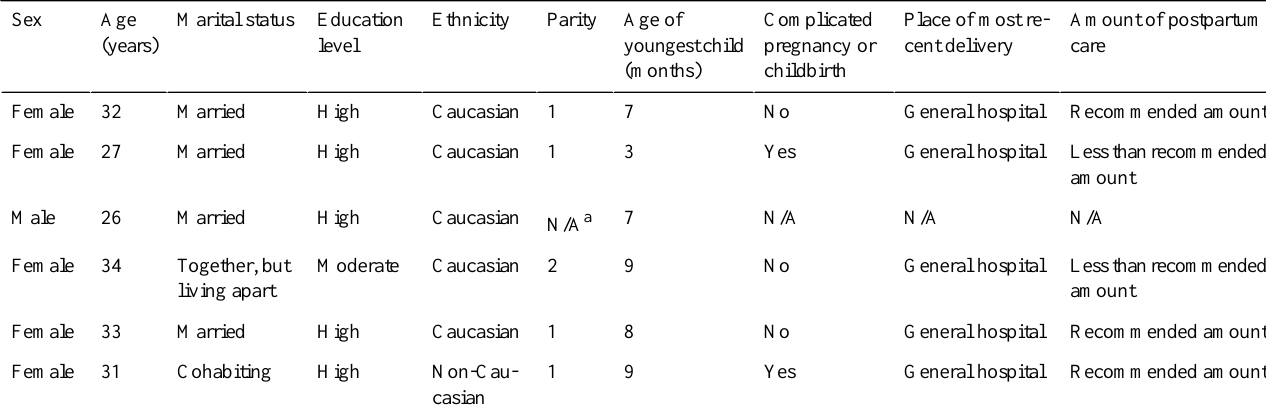
Table 1. Characteristics of participants: parents of